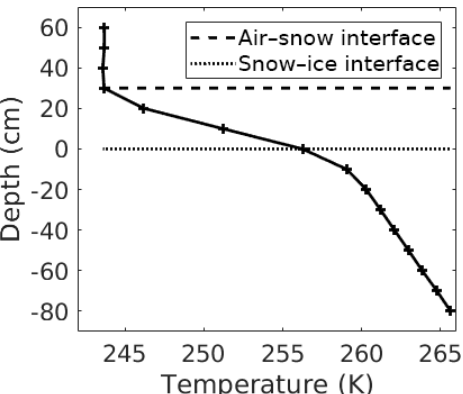
Figure 4. Averaged temperature profile (from December to Febru- ary) measured by the IMB 2012G, with air–snow and snow–ice in- terface levels detected with our automated